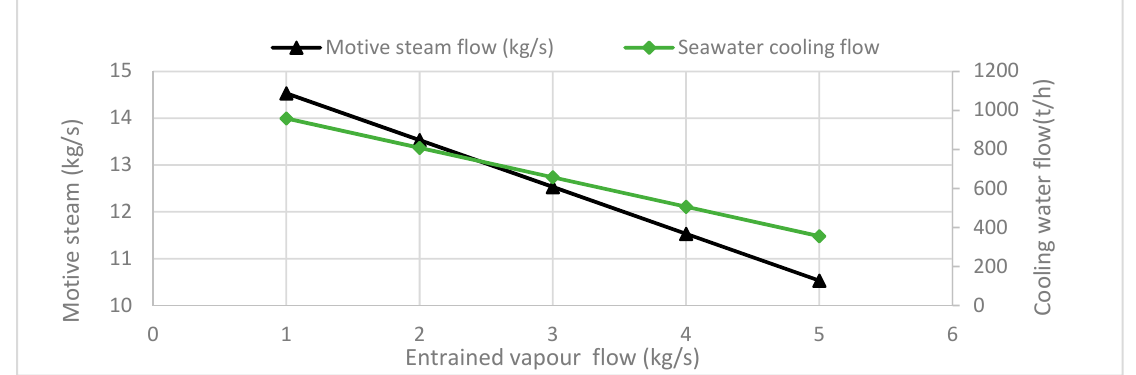
Figure 5. Motive steam and cooling water flow versus entrained vapour flow.